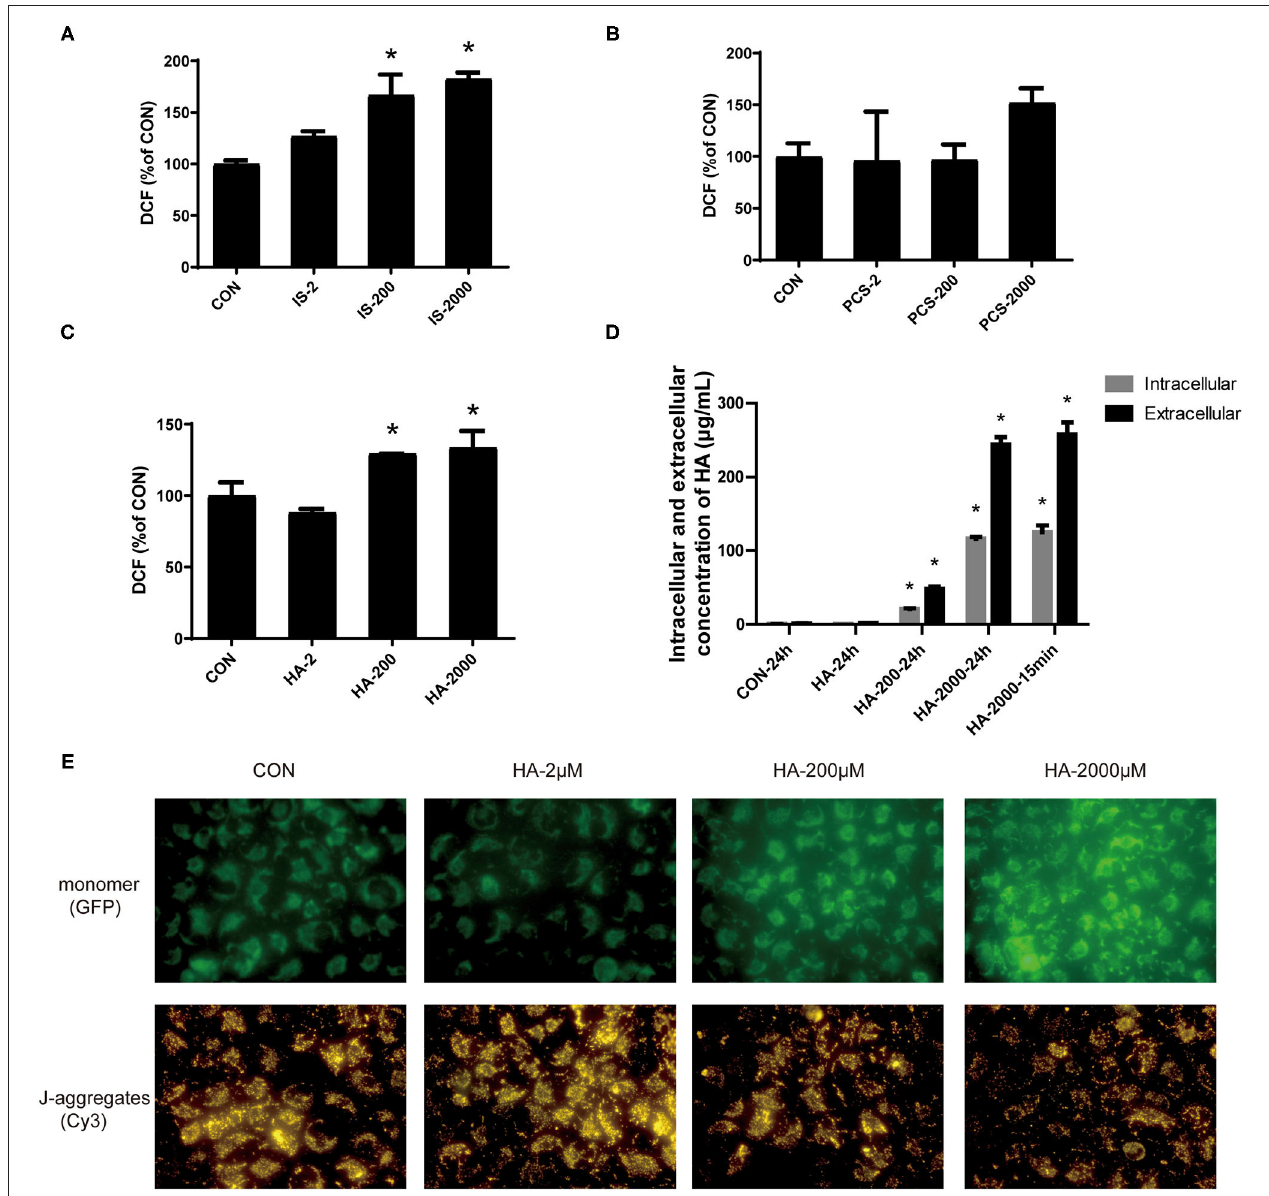
FIGURE 4 | PBUTs induced reactive oxygen species (ROS) generation and mitochondria mitochondrial damage in the hepatocytes. (A) Effects of IS on ROS production in THLE-2 cells. (B) Effects of PCS on ROS production in THLE-2 cells. (C) Effects of HA on ROS production in THLE-2 cells. After treatment, cells were stained with DCFH-DA and measured by flow cytometry ( n = 3). (D) Intracellular and extracellular HA concentration in THLE-2 cells cultured with different doses of HA after 24h or 15min ( n = 3). (E) Effects of HA on mitochondrial membrane potential (MMP) in THLE-2 cells. After 24h HA treatment, cells were stained with JC-1 solution to measure MMP level. For all bar graphs, data are the mean ± SD. *, P < 0. 05 vs. CON group. The significant difference was assessed using the one-way ANOVA followed by LSD